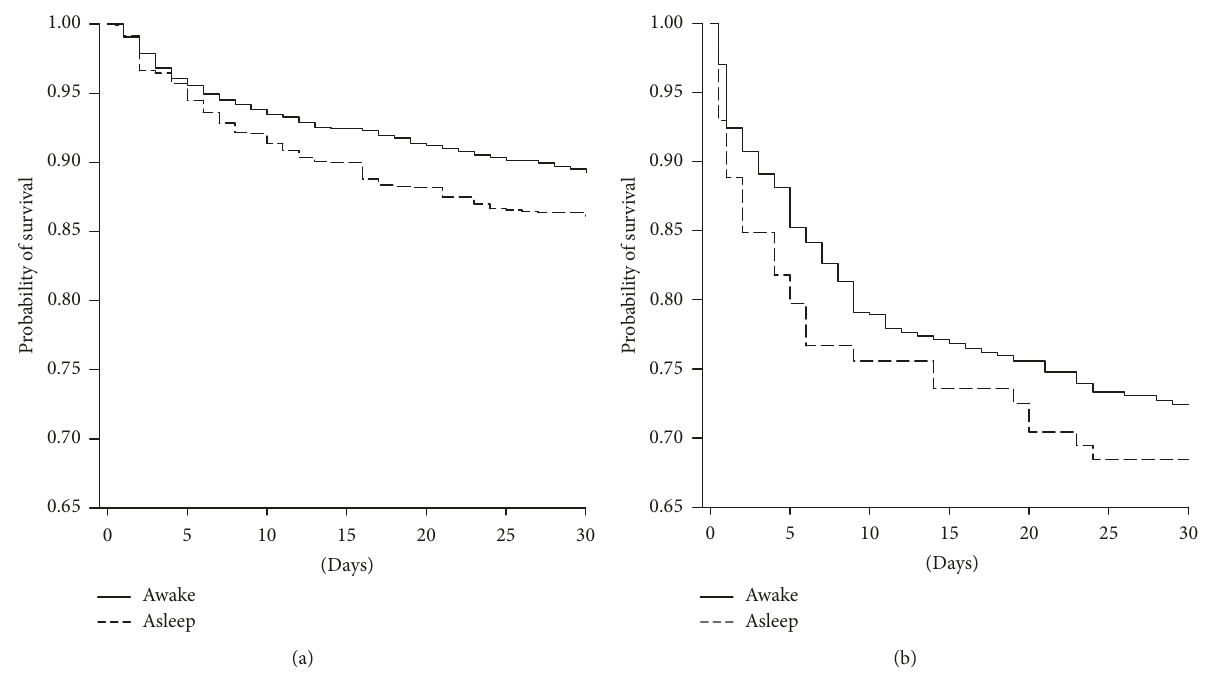
Figure 1: Short-term survival probability (Kaplan-Meier estimates) between awake and asleep onset in (a) ischemic and (b) hemorrhagic stroke. (a) = 𝑝 = 0.025 ; (b) =